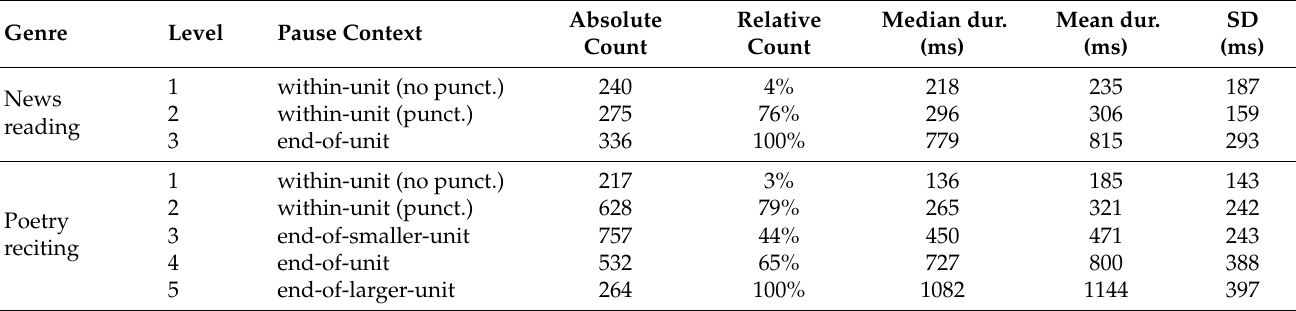
Table 1. Occurrence (absolute and relative) of pauses and their duration as a function of the level of overt text structure in two genres (for an explanation of levels, see Section 2.3). The relative occurrence denotes the percentage of realized to potential pauses in the given context (for instance, the ends of lines offer more opportunities to pause than the ends of stanzas due to their different numbers).